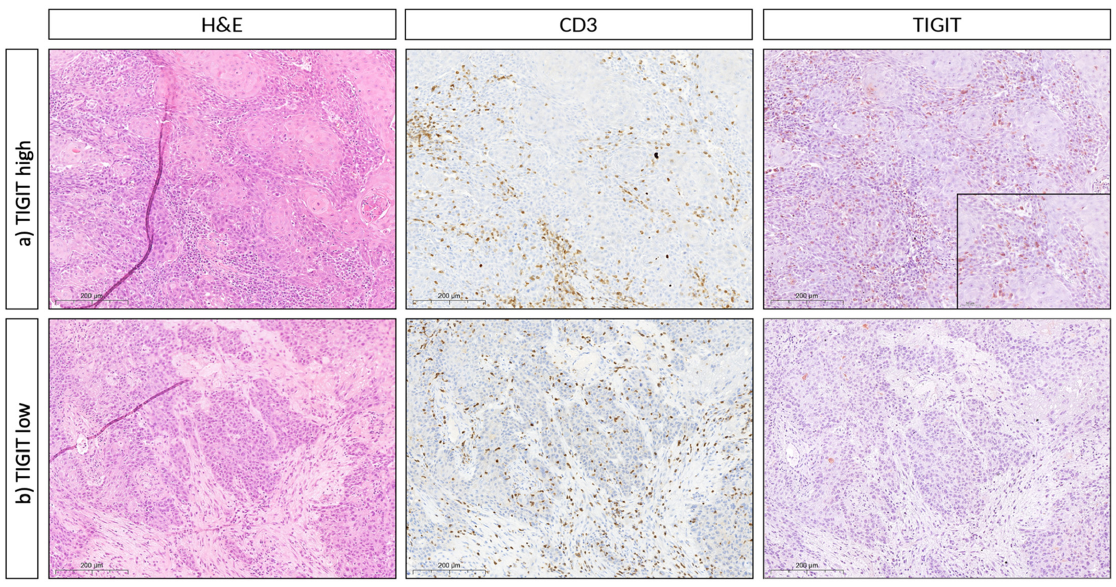
7 of 14 Figure 2. ( a,b ): Impact of TIGIT and CD274 mRNA expression levels on overall survival of OSCC patients, generated from the cBioPortal TCGA Firehose Legacy dataset. Groups were divided based on the median. ( c ) An additional analysis of TIGIT / CD274 co − expression demonstrated higher CD274 levels in patients with high TIGIT mRNA expression levels. 3.3. Expression of TIGIT on CD3+ Cells Correlates with Improved Survival of OSCC Patients To evaluate the TIGIT expression on the protein level, we examined an OSCC TMA and correlated available clinicopathological parameters with TIGIT expression in CD3+ cells. Figure 3 shows hematoxylin & eosin as well as IHC staining (CD3 and TIGIT) in two